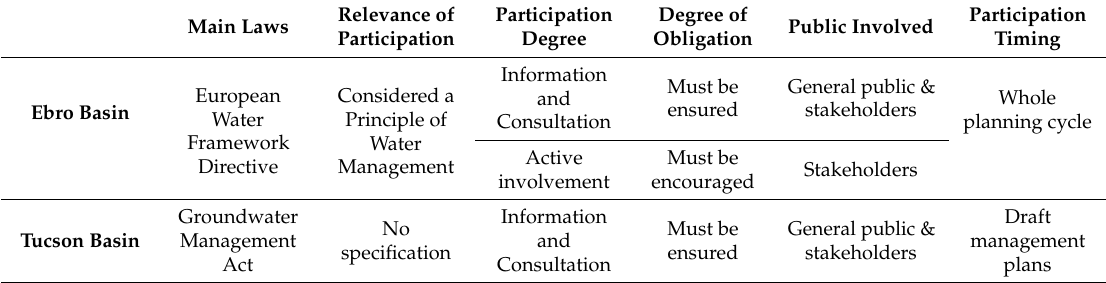
Table 6. Comparison of case studies legal